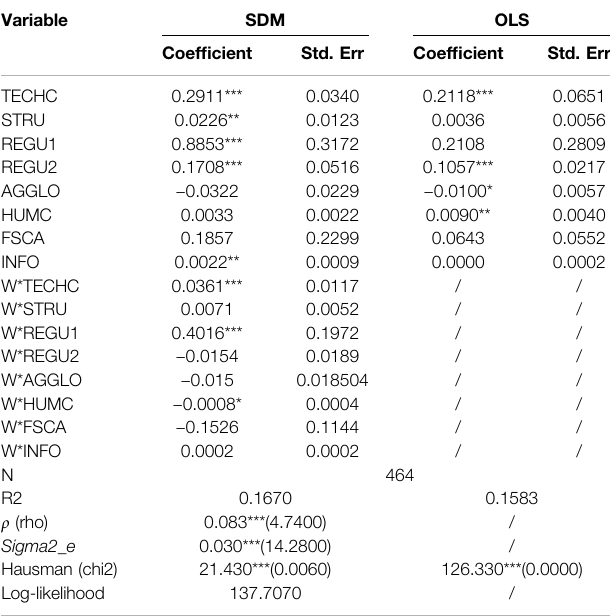
TABLE 7 | Spatial panel model estimation